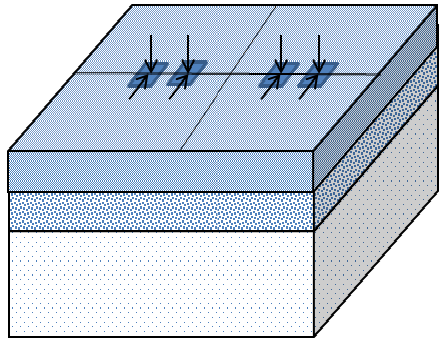
Figure 2. Schematic diagram and load arrangement of the bridge deck pavement.